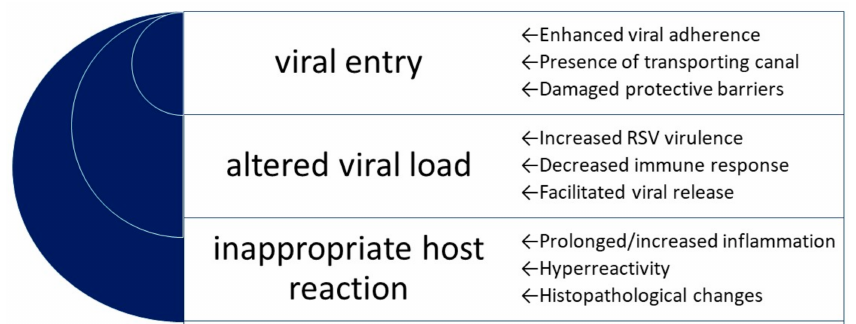
Figure 1. A schematic presentation of the expected directions of air pollution influence on RSV mor- bidity and disease course; three major concepts are shown in the centre, alongside the corresponding putative pathways on the